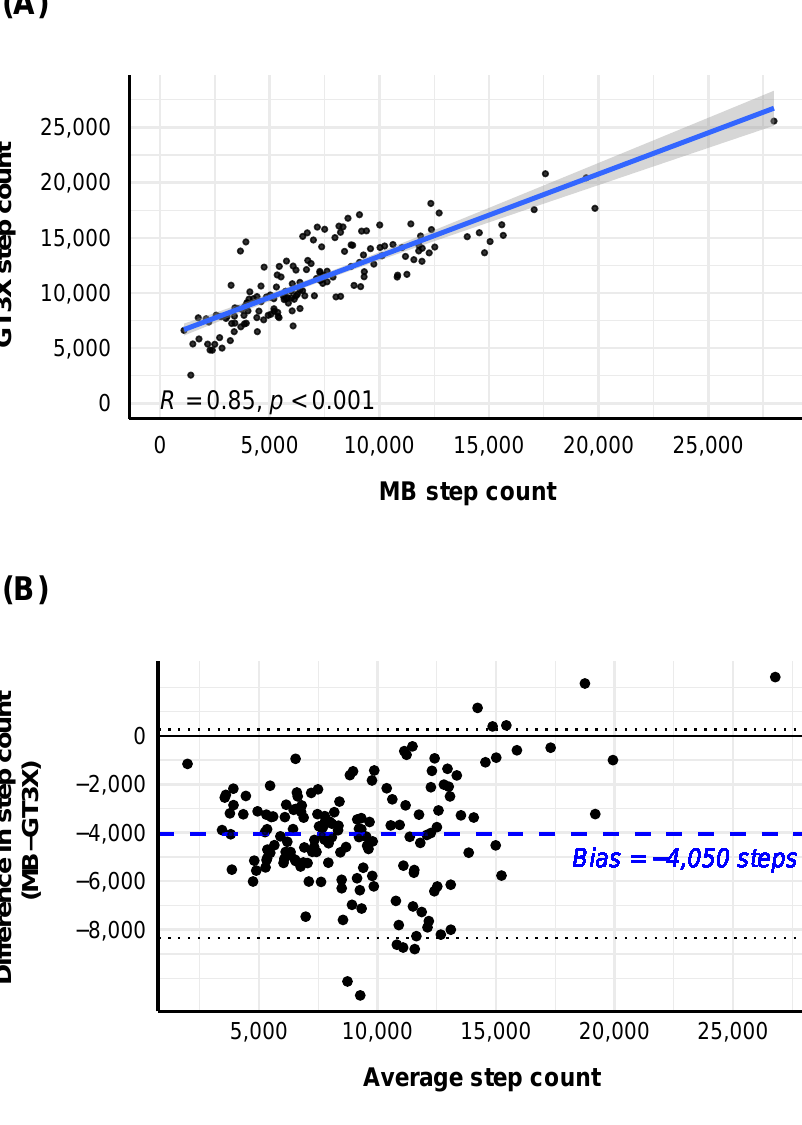
Figure 1. Correlation and agreement analysis between the GT3X and MB on step counts. ( A ) Spearman’s correlation between the GT3X and MB step counts for each day and participant. ( B ) The Bland–Altman plot shows the difference between per-day step count as extracted by the GT3X and MB (y axis) and their average (x axis). Note the high agreement between the two devices ( A ), although there is a clear bias of the MB device to underestimate steps especially in cases with fewer average steps per day ( B ). The dashed blue line illustrates the mean difference (i.e., bias) between the two measurements; the dotted lines represent the 95% CI limits of the mean difference; and the black solid line represents the point of equality (where the difference between the two devices is equal to